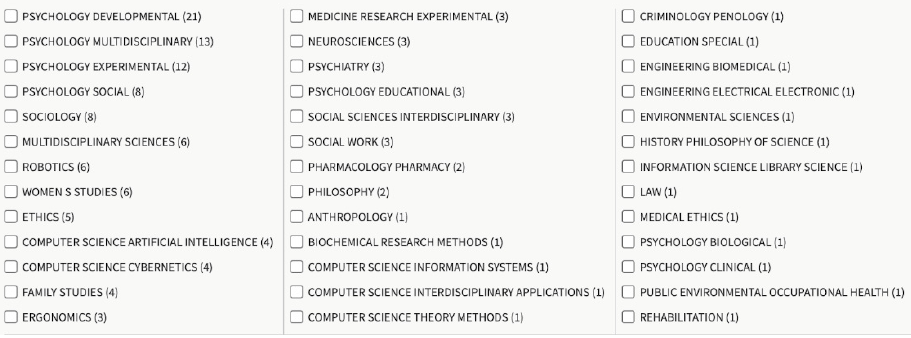
Figure 3. Topics selected in Web of Science (WoS) database.